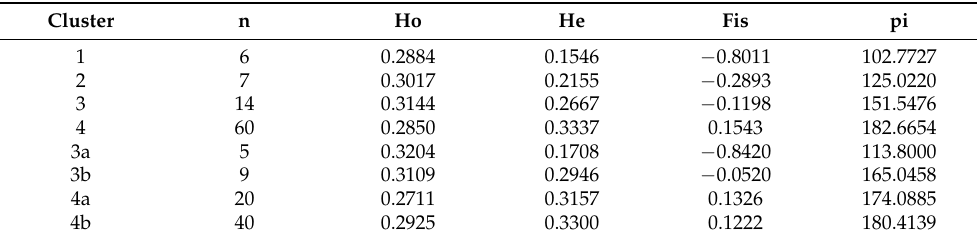
Table 2. Genetic diversity indexes for the Clusters obtained with the PCA based dendrogram. Expected heterocigosity (He), observed Heterocigosity (Ho) and, inbreeding coefficient (Fis) and nucleotide diversity